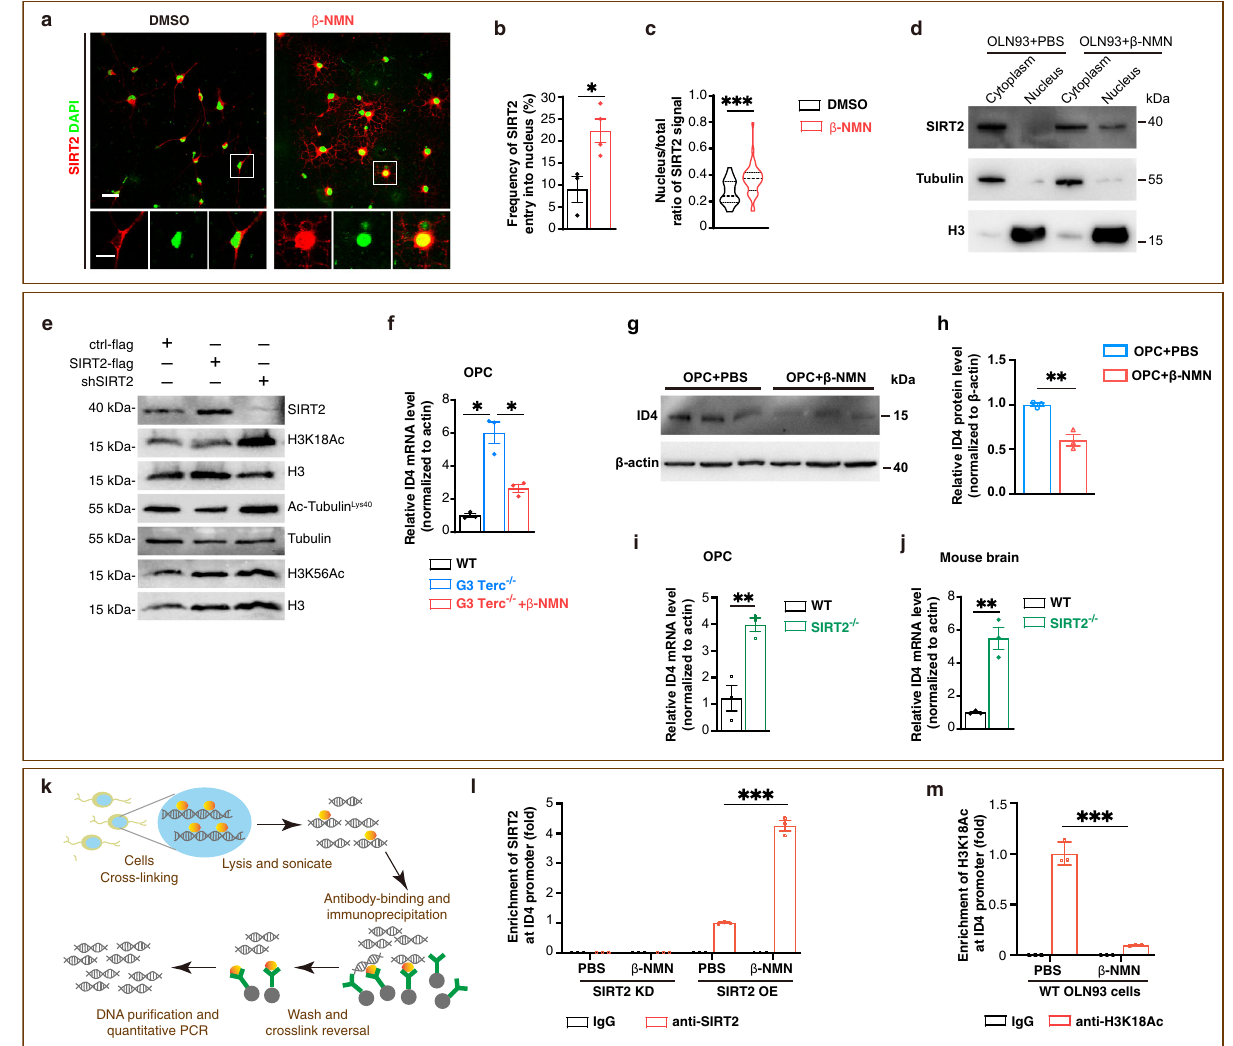
Fig. 7 β -NMN induces the nuclear entry of SIRT2 and suppresses transcription of ID4, thus promoting OPC differentiation in vitro. a Images of SIRT2 entry into the nucleus in primary cultured mouse OPCs. SIRT2 (red), DAPI (green). Scale bar, 20 μ m for the upper panel, 10 μ m for the lower panel. b Quanti fi cation of the proportion of SIRT2 entry into the nuclei ( n = 3 for the DMSO group, n = 4 for the β -NMN group). c Quanti fi cation of the nucleus/ total ratio of SIRT2 signal ( n = 37 cells for the DMSO group, n = 36 cells for the β -NMN group). d Western blot of SIRT2 using nuclear and cytoplasmic fractionation of OLN93 cells treated with β -NMN or PBS. e Immunoblotting of SIRT2 and its possible downstream molecular targets (H3K18Ac, Ac- Tubulin Lys40 and H3K56Ac, H3 and Tubulin serve as internal reference) regulated by overexpression or knockdown of SIRT2 in OLN93 cell line. ctrl- fl ag: pCDH-EF1 α -MCS- fl ag-P2A-copGFP, SIRT2- fl ag: pCDH-EF1 α -SIRT2- fl ag-P2A-copGFP, shSIRT2: pGreenPuro-shSIRT2. f Relative mRNA level of ID4 in primary cultured OPCs of WT and G3 Terc − / − mice ( n = 3). g , h Western blots of ID4 in primary cultures rat OPCs treated with DMSO or β -NMN for 48 h ( n = 3). i Relative mRNA level of ID4 in primary cultured OPCs of WT and SIRT2 − / − mice ( n = 3). j Relative mRNA level of ID4 in the brains of WT and SIRT2 − / − mice ( n = 3). k Schematic of the protocol for ChIP-qPCR. l ChIP-qPCR assessment of the enrichment of SIRT2 at the promoter region of ID4 in OLN93 cell line knocking down or overexpressing SIRT2 ( n = 3). m ChIP-qPCR assessment of the enrichment of H3K18Ac at the promoter region of ID4 in WT OLN93 cell line ( n = 3). All data are presented as mean ± SEM. The center, upper and lower line represent the median, upper and lower quartiles, respectively ( c ). * p < 0.05, ** p < 0.01, *** p < 0.001 by two-tailed t -test ( b , h – j ), one-way ANOVA followed by Tukey ’ s post hoc test ( f ) or two-way repeated ANOVA followed by Sidak ’ s post hoc test ( l – m ). In all instances *** p < 0.001. n.s . no signi fi cance. In ( b ), * p = 0.0219, In ( f ), * p = 0.04 (WT vs.